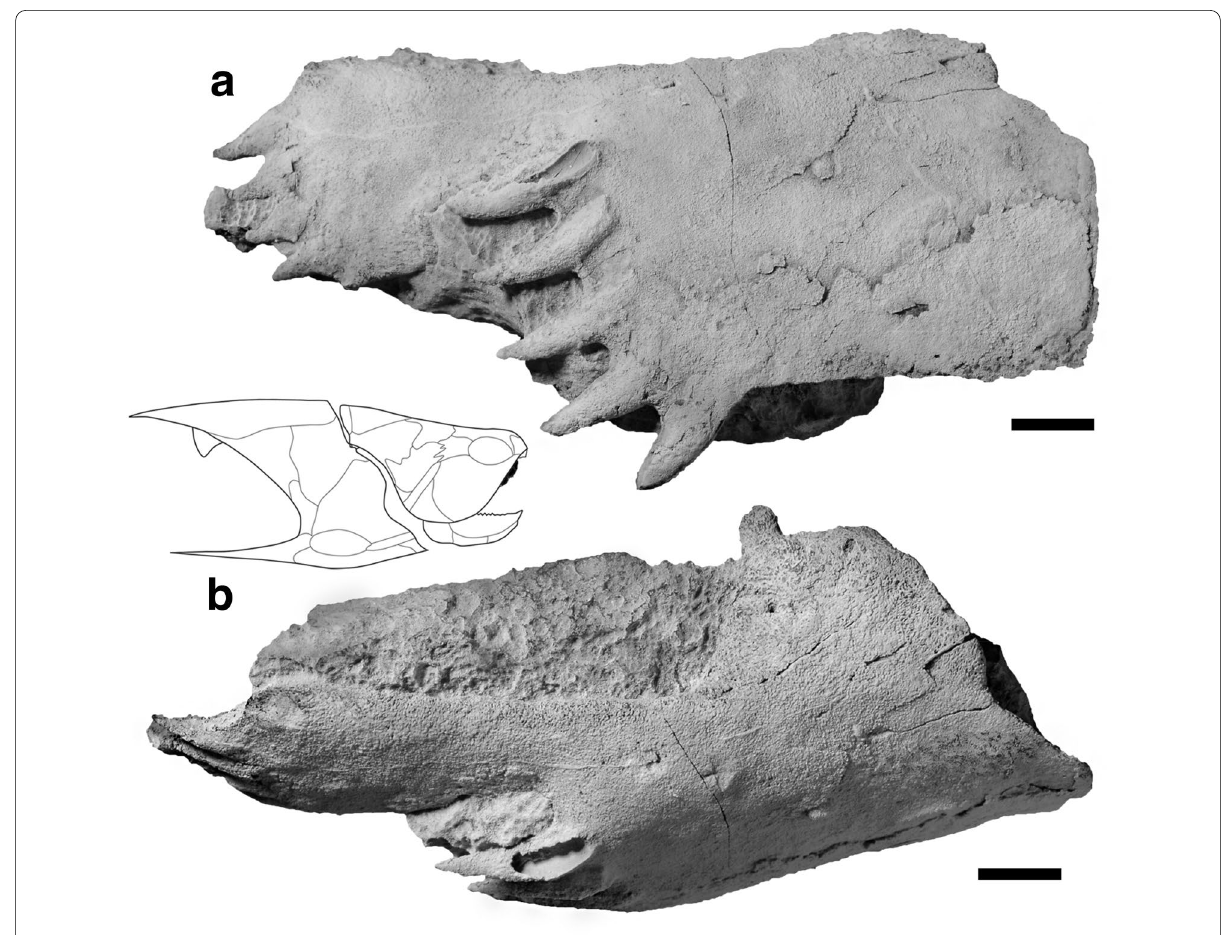
Fig. 2 Posterior superognathal (PSG) of Leptodontichthys ziregensis gen. et sp. nov. (PIMUZ A/I 5022), holotype, Drotops -Limestone, Middle Devonian, Jebel Zireg, Morocco in labial ( a ) and dorsal view ( b ). Teeth point caudally. The PSG is highlighted in black in the reconstruction of the eubrachythoracid Coccosteus . Scale bar represents 10